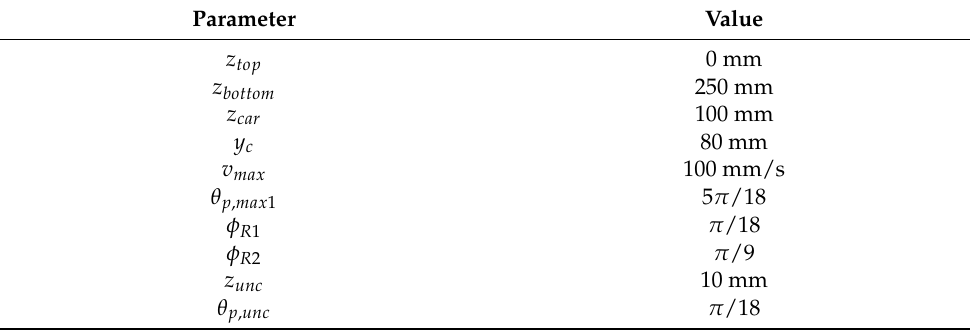
Table 1. The parameters for the instantaneous search